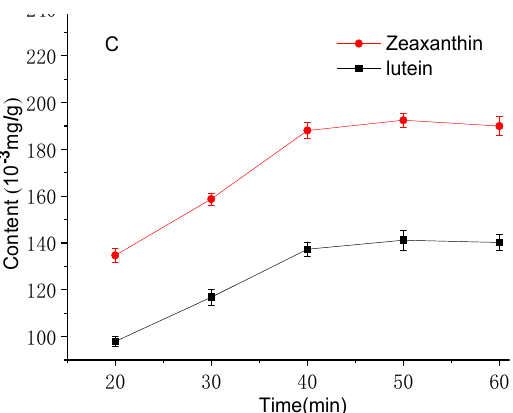
Figure 2. The effect of ( A ) solid–liquid ratio, ( B ) temperature, and ( C ) extraction time on the content of zeaxanthin and lutein ( n = 3).